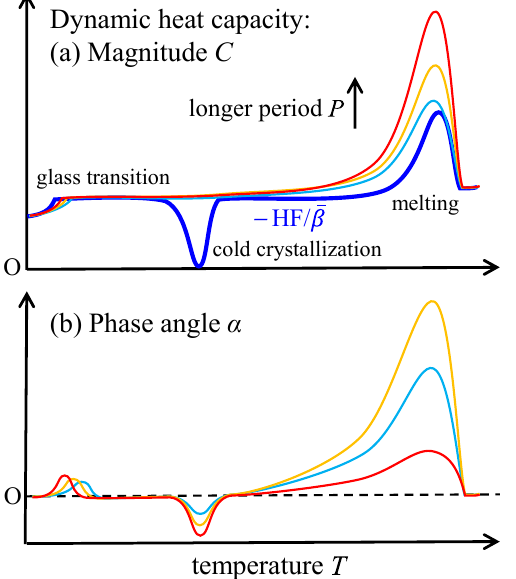
Figure 2. Schematic drawing of typical responses of glass transition, cold crystallization and melting to a periodic temperature modulation, which appear in ( a ) C and ( b ) α and show the indicated dependences on applied modulation period. In ( a ), thick line represents −HF/𝛽̅ .